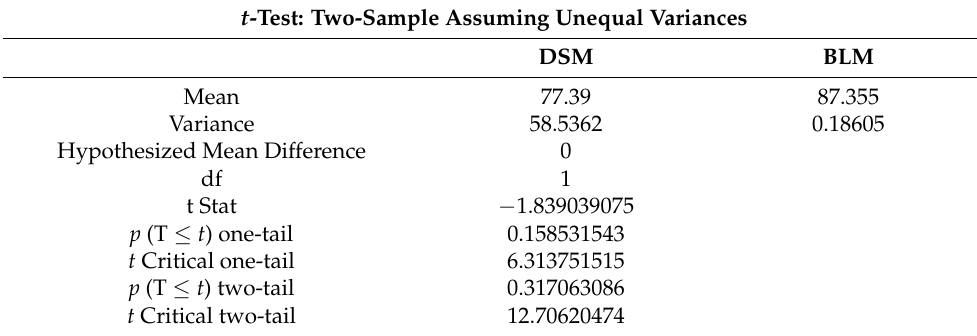
Table 8. Statistical comparison of DSM and BLM based on multiclass classification results. t -Test: Two-Sample Assuming Unequal